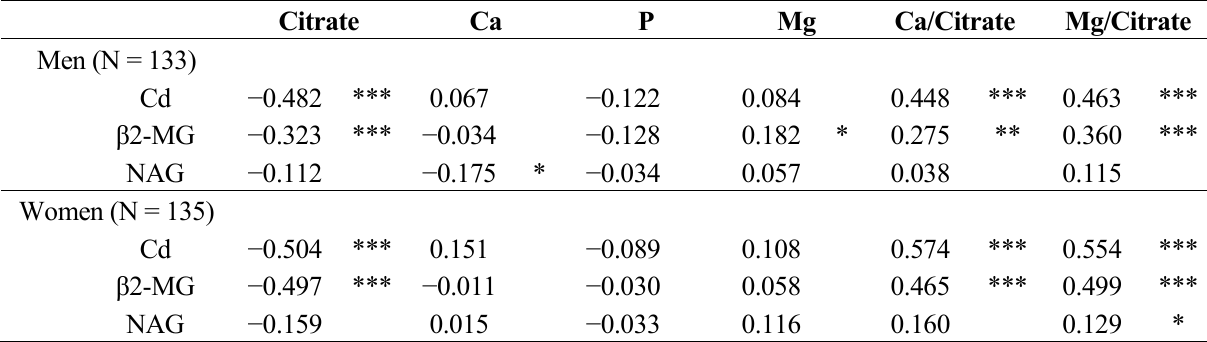
Table 4. Correlation coefficients (Spearman’s ρ ) of citrate, calcium and magnesium in urine with Cd and renal tubular markers among the subjects participated in 2012 survey.